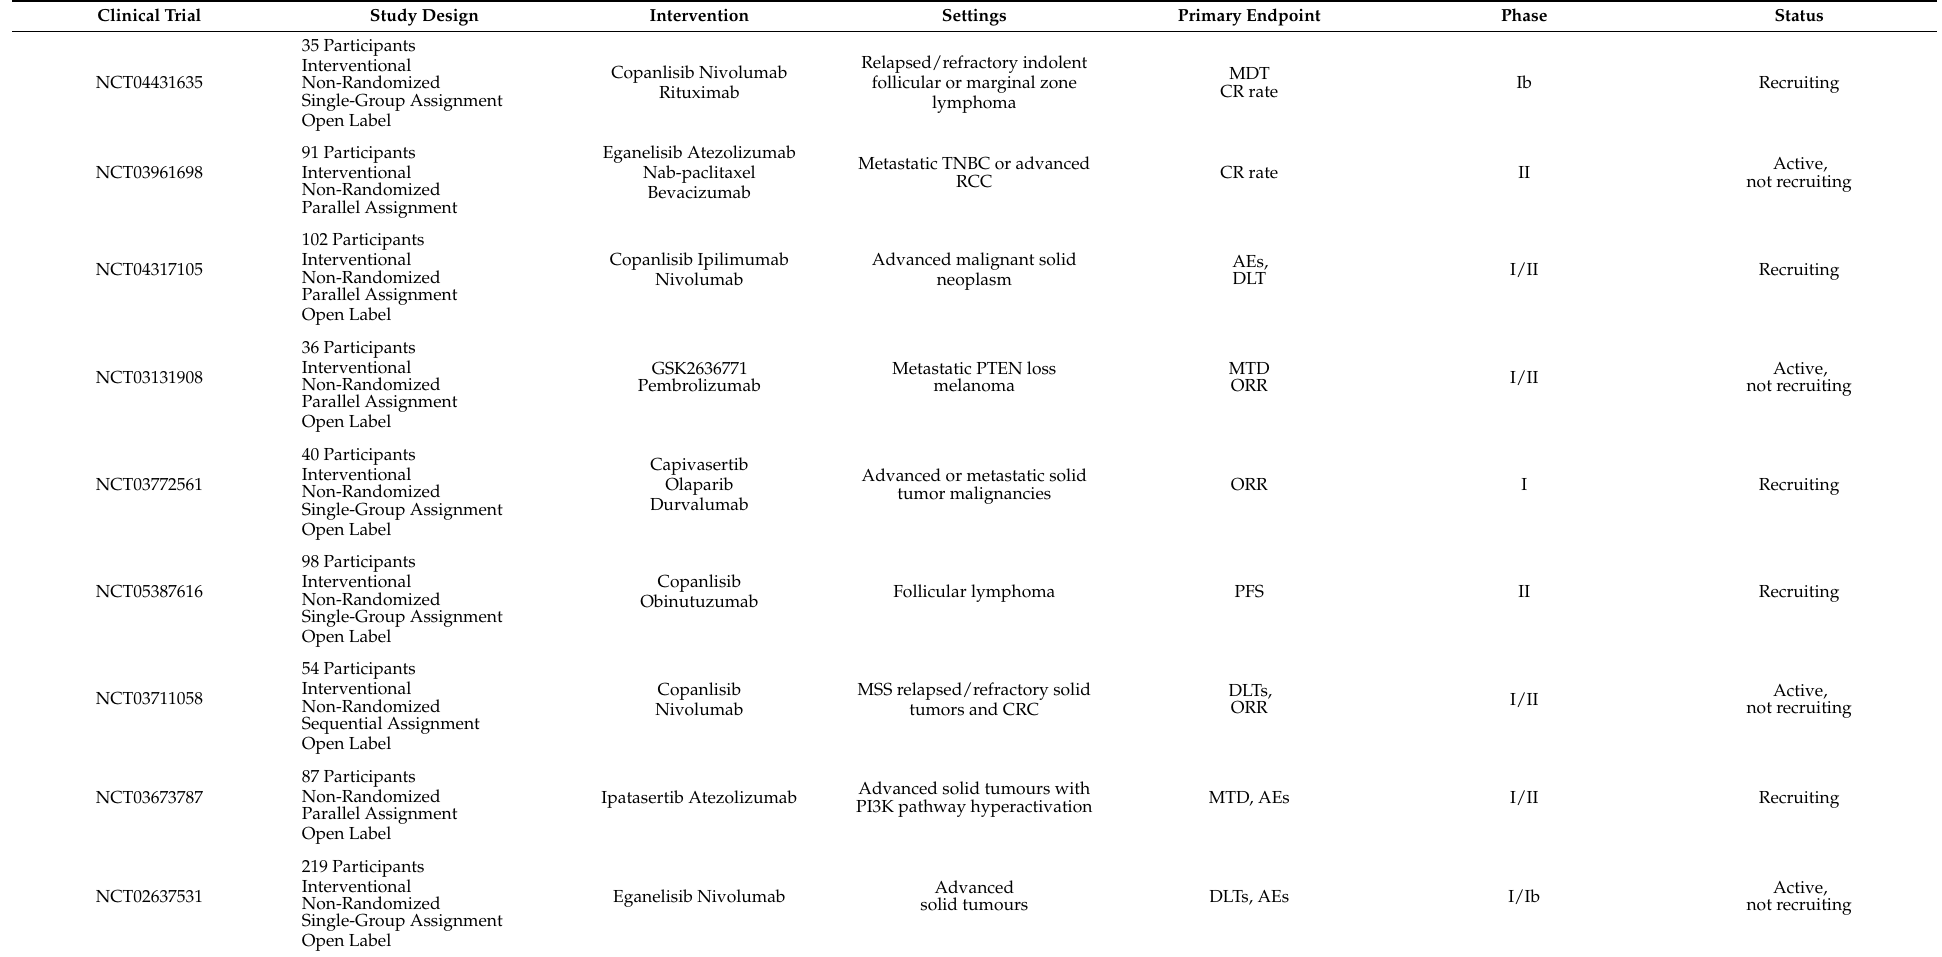
Table 4. Ongoing clinical trials combining immune checkpoint inhibitors with inhibitors of the PI3K/AKT/mTOR pathway. Clinical